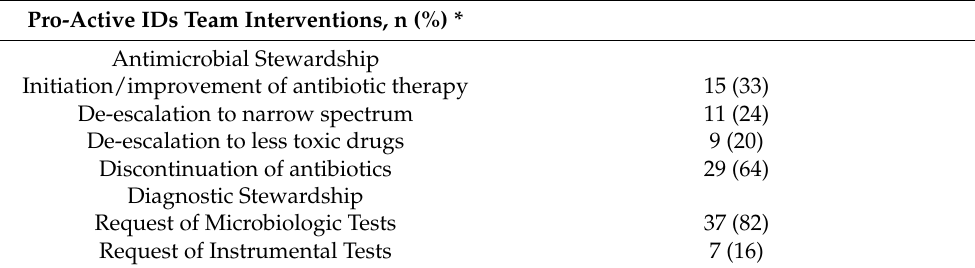
Table 3. Antimicrobial and diagnostic stewardship intervention. Pro-Active IDs Team Interventions, n (%) * Antimicrobial